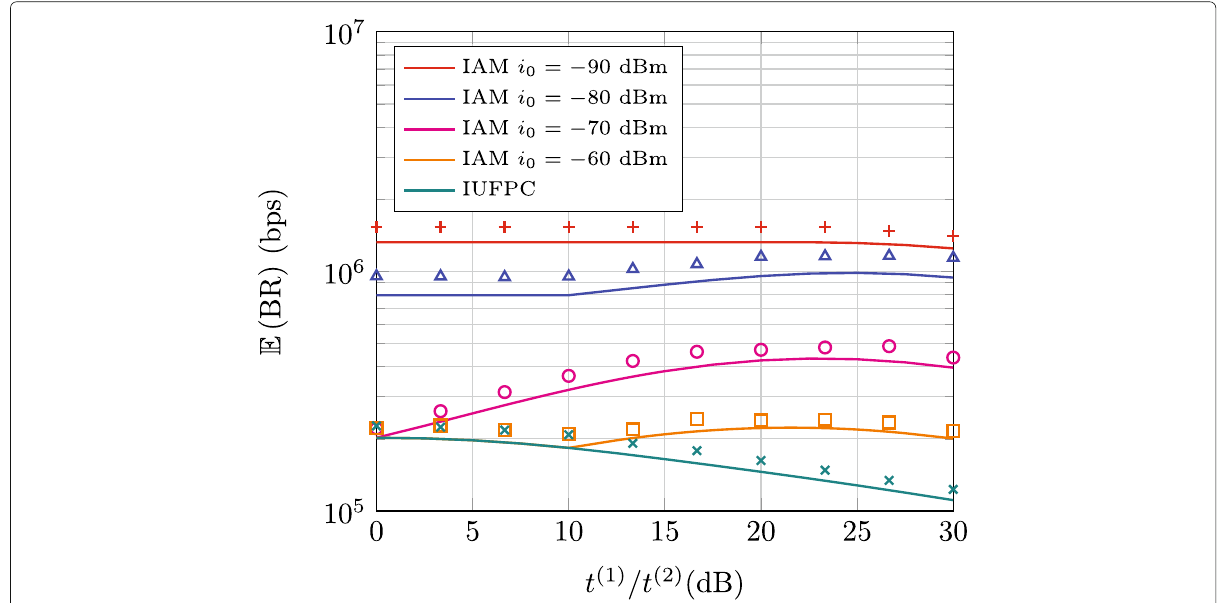
Fig. 12 Average BR as a function of t ( 1 ) / t ( 2 ) for IUFPC ( i 0 → ∞ ) and IAM with i 0 = {− 90, − 80, − 70, − 60 } dBm. p max → ∞ for both